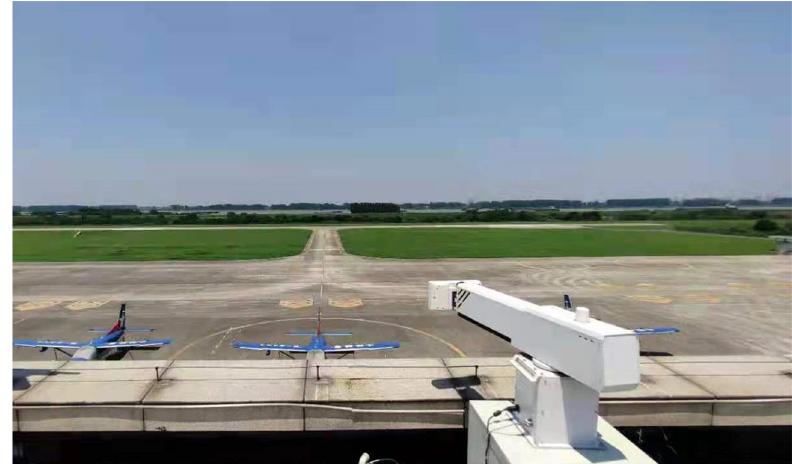
Figure 7. AS-SAR and its working field scene.